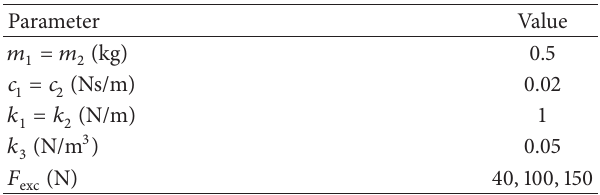
Table 1: Simulation parameters of the numerical